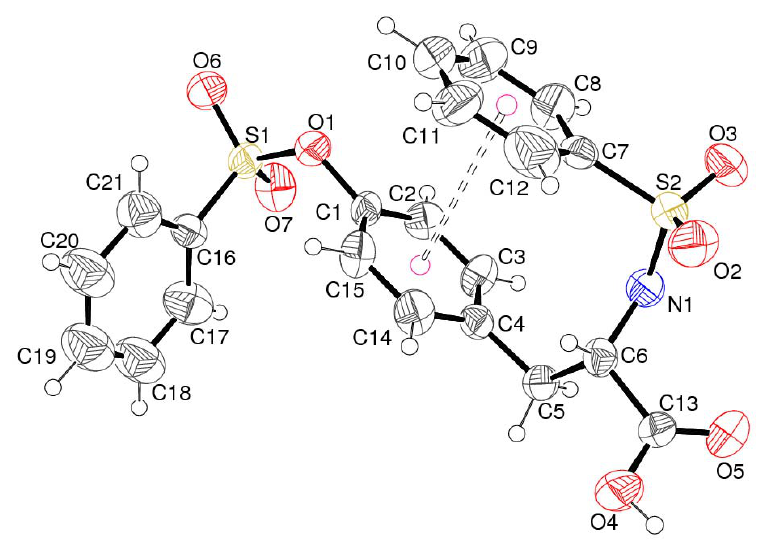
Figure 2. The molecular structure of molecule 1A showing 40% displacement ellipsoids. The intramolecular  –  stacking interaction is indicated by a double-dashed